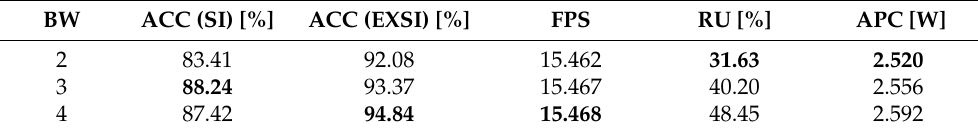
Table 9. Results of cloud coverage classification for best-performed quantized models on